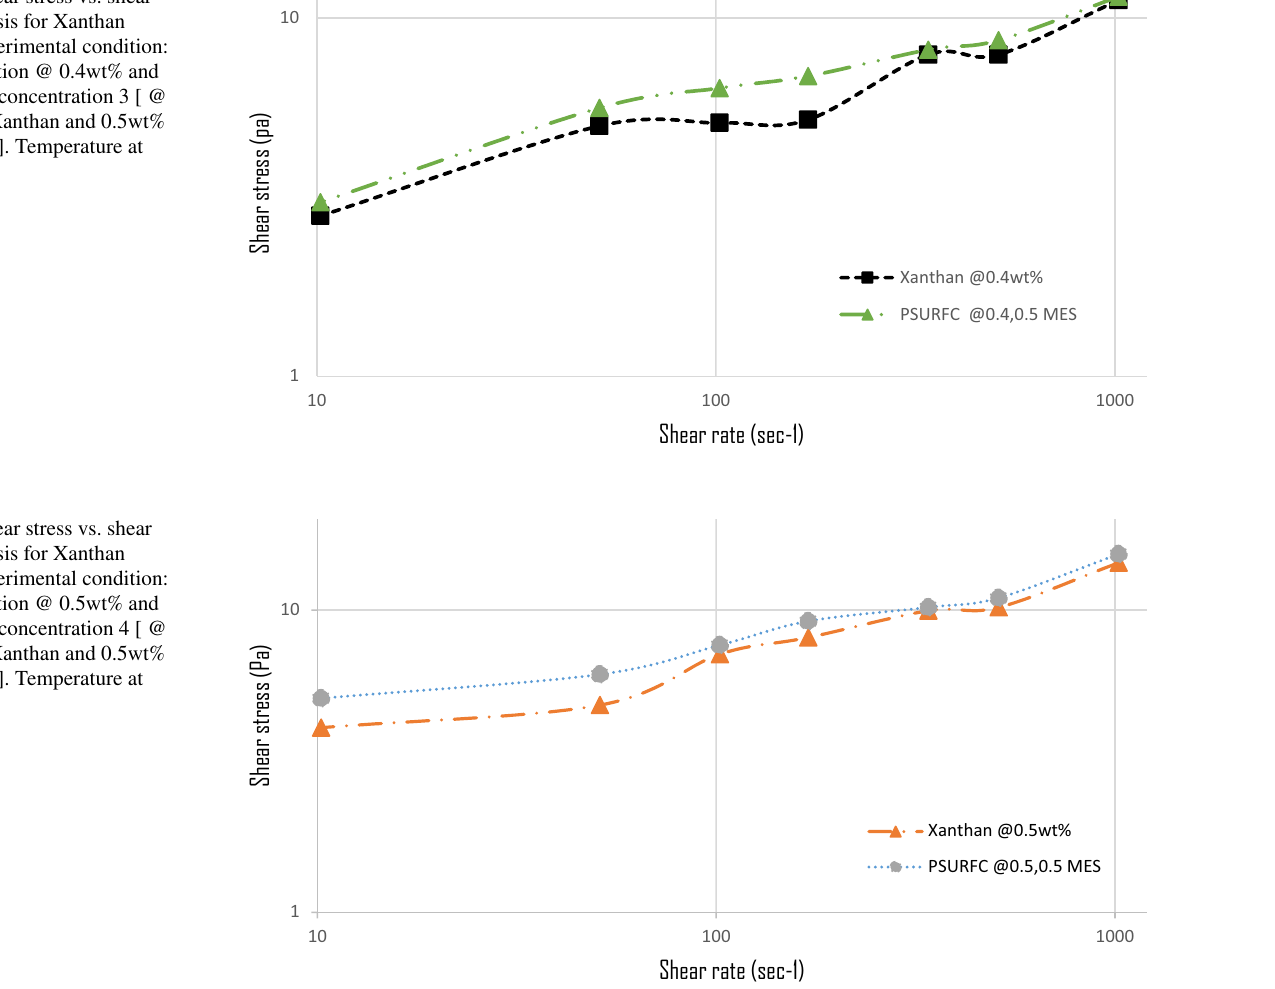
Fig. 4 Shear stress vs. shear